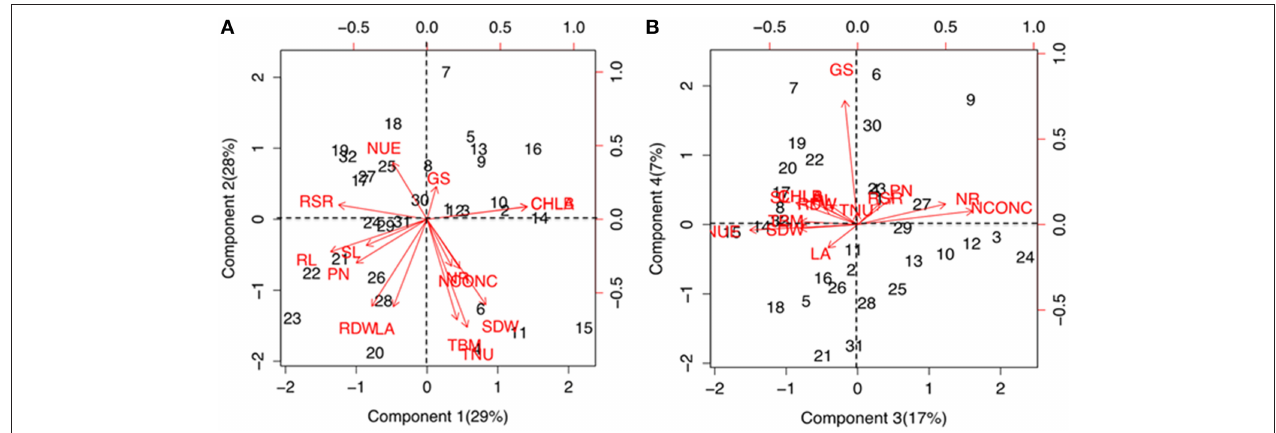
FIGURE 1 | Biplot showing principal component scores (A) PC1, PC2 and (B) PC3, PC4 of traits governing nitrogen starvation tolerance in maize genotypes grown under low (50 µ M) N. The factor loading values for traits are indicated by red arrows radiating from the center showing the direction (angle) and magnitude (length). Data labels indicate 32 maize genotypes as mentioned in Supplementary Table 1. Legend for traits: SL, shoot length; RL, root length; SDW, shoot dry weight; RDW, root dry weight; TBM, total biomass; RSR, root-to-shoot ratio; LA, leaf area; CHL A, chlorophyll a; CHL B, chlorophyll b; PN, photosynthesis; NCONC, N concentration; TNU, total N uptake; NUE, N use efficiency; NR, nitrate reductase; GS, glutamine synthetase.